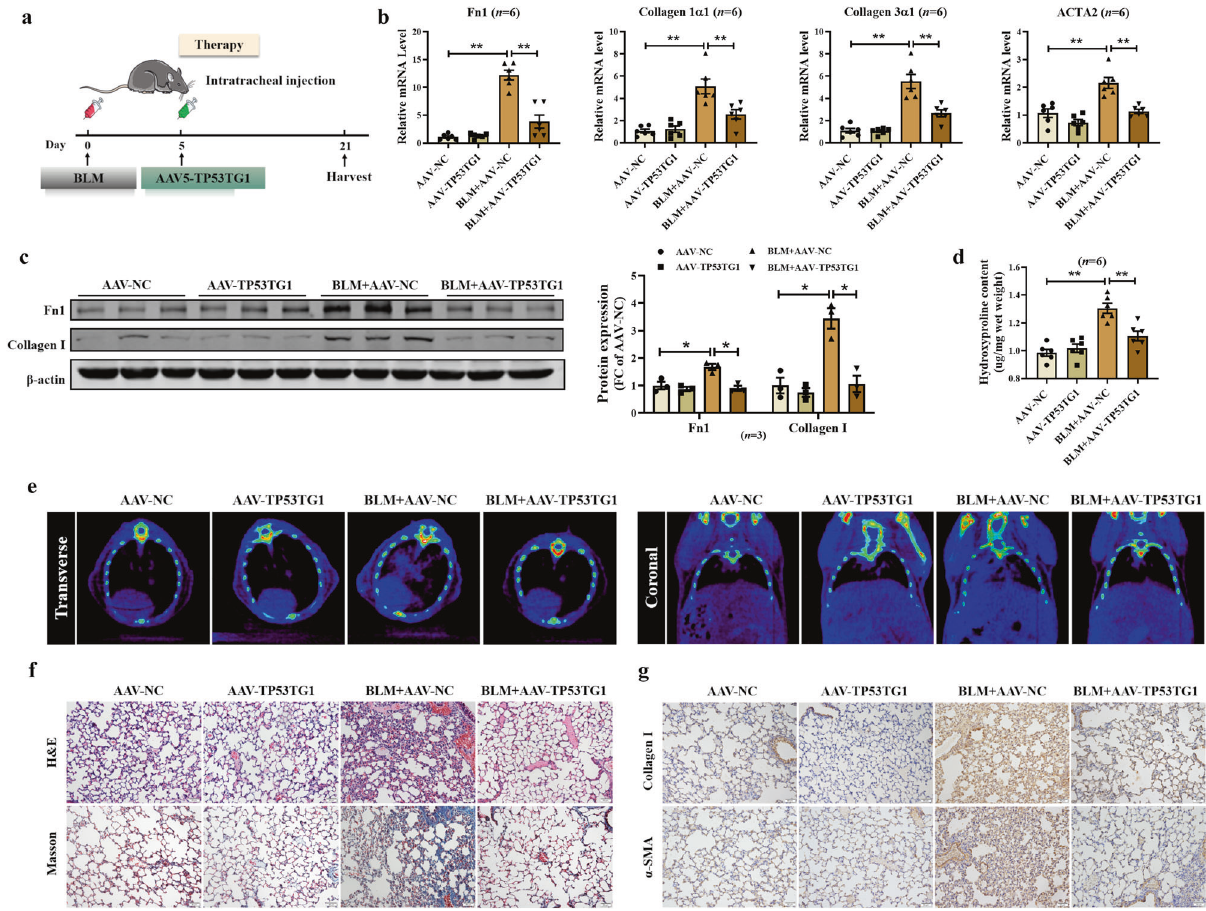
Fig. 6 Inhibitory effect of therapeutic TP53TG1 on pulmonary fi brosis. a Diagram of the experimental animal model of therapeutic TP53TG1. Mice were intratracheally injected with AAV-TP53TG1 at day fi ve after induction by BLM and sacri fi ced 21 days later. b Fibrosis markers mRNA level of Fn1, Collagen 1 α 1, Collagen 3 α 1, and ACTA2 in lungs after BLM/TP53TG1 treatment. c After fi brosis formation, TP53TG1 inhibited the relative protein expression of Fn1 and Collagen I. d BLM increased hydroxyproline content, which was reversed upon AAV5- TP53TG1 treatment. e CT scans of foci in the lung of mice; n = 3. f Therapeutic TP53TG1 alleviated BLM-induced fi brotic changes in lung tissue detected by H&E and Masson staining; n = 3. g Immunohistochemical staining showed that AAV5-TP53TG1 regulated the expression of Collagen I and α -SMA in lung tissues; n = 3. * P < 0.05; ** P < 0.01. AAV-TP53TG1, adeno-associated virus 5 containing TP53TG1; FC fold